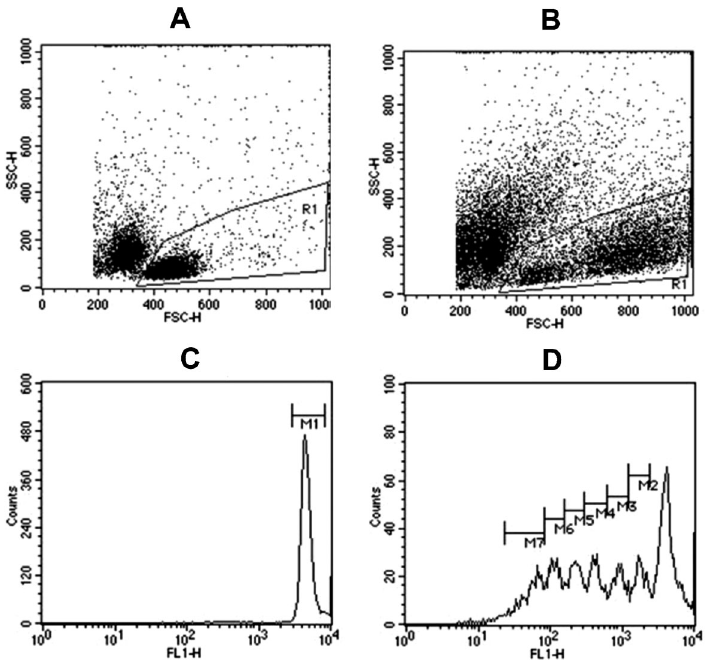
Figure 1. Analysis of cell proliferation using carboxyfluorescein succinimidyl ester (CFSE) by flow cytometry. A , Control for unstimulated cultures; B , phytohemagglutinin-stimulated cul- tures; C , CFSE-stained cells derived from unstimulated cultures; D , CFSE-stained cells in cultures stimulated with PHA. SSC and FSC = side and forward scatter,